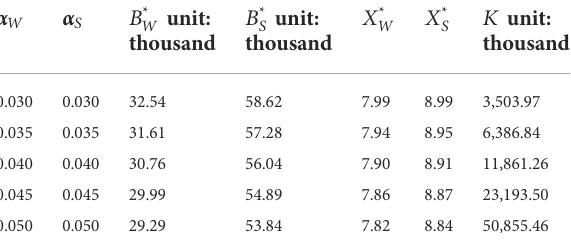
TABLE 4 The in fl uence of the σ i , i (cid:2) W , S of shift variable on B * W , B * S , X *